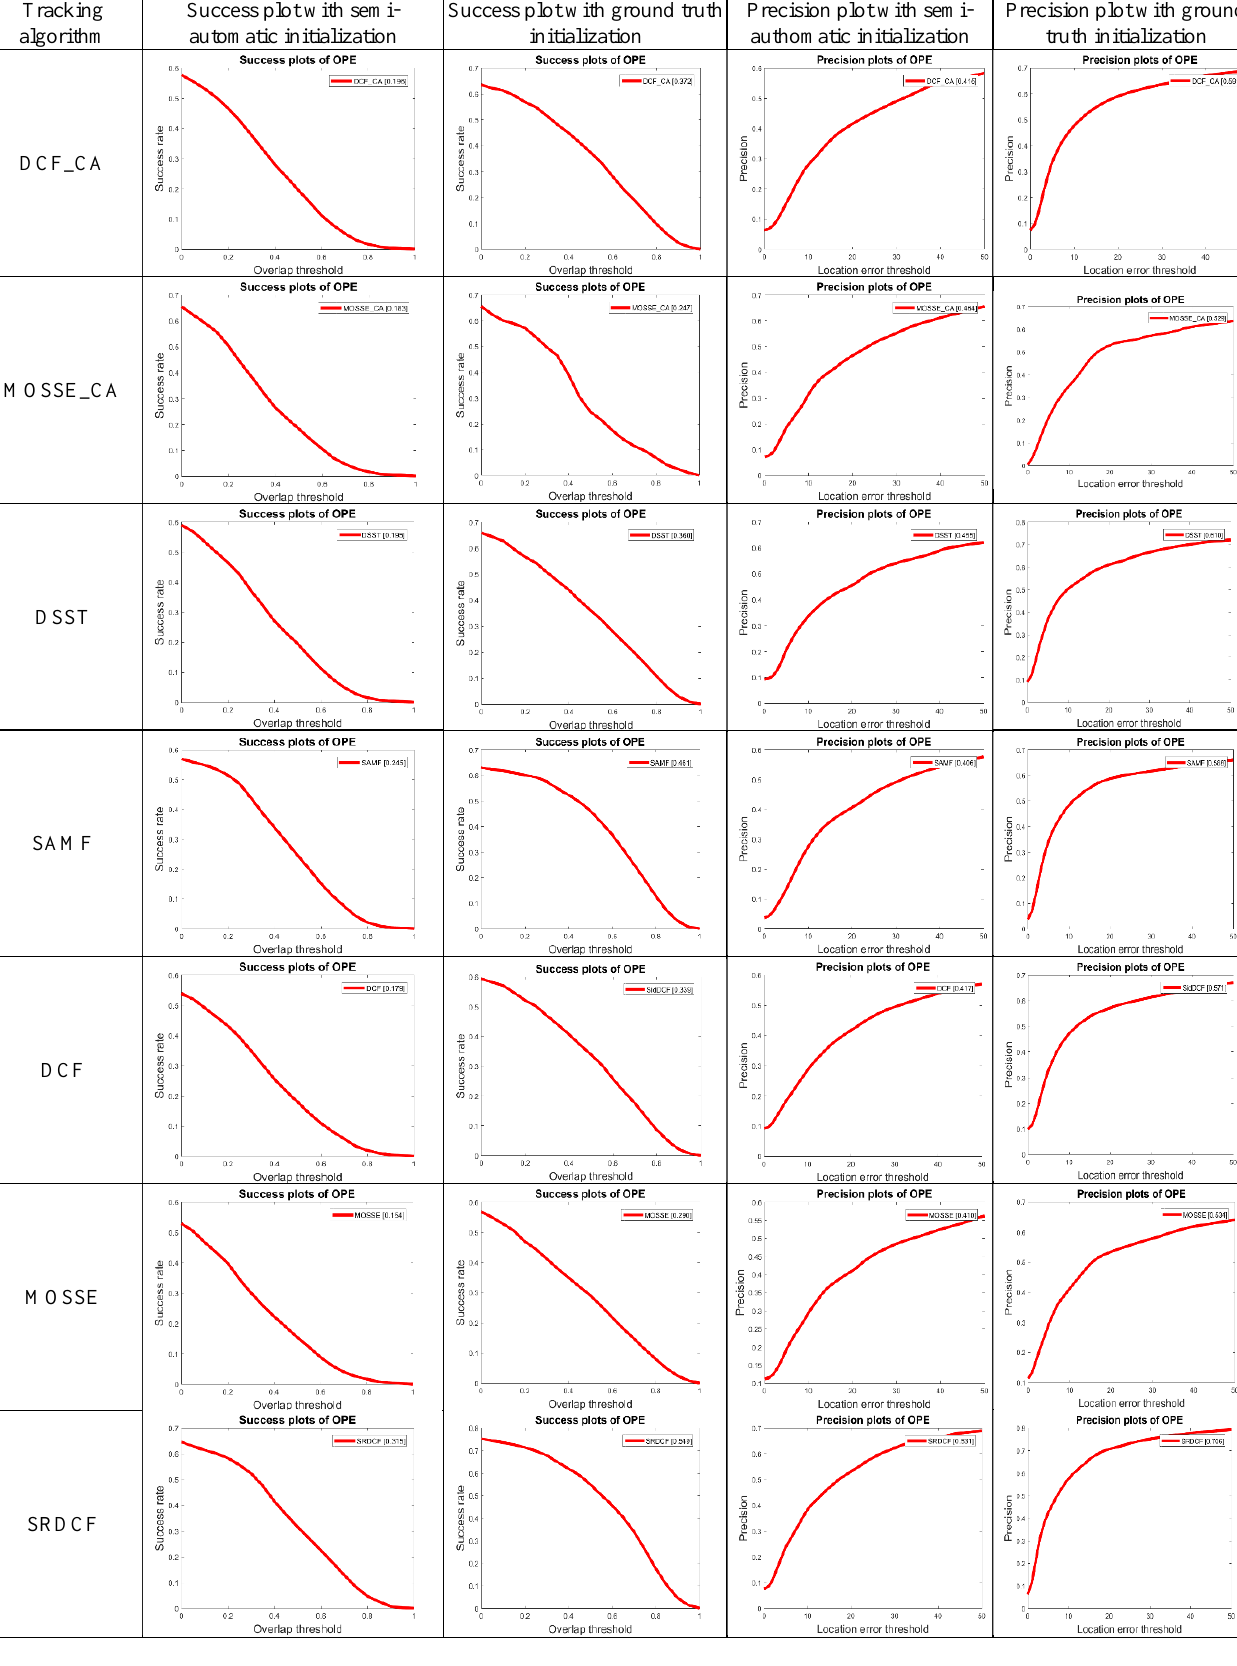
Table 2. Success and precision graphs of different tracking algorithms with semi-automatic and ground truth